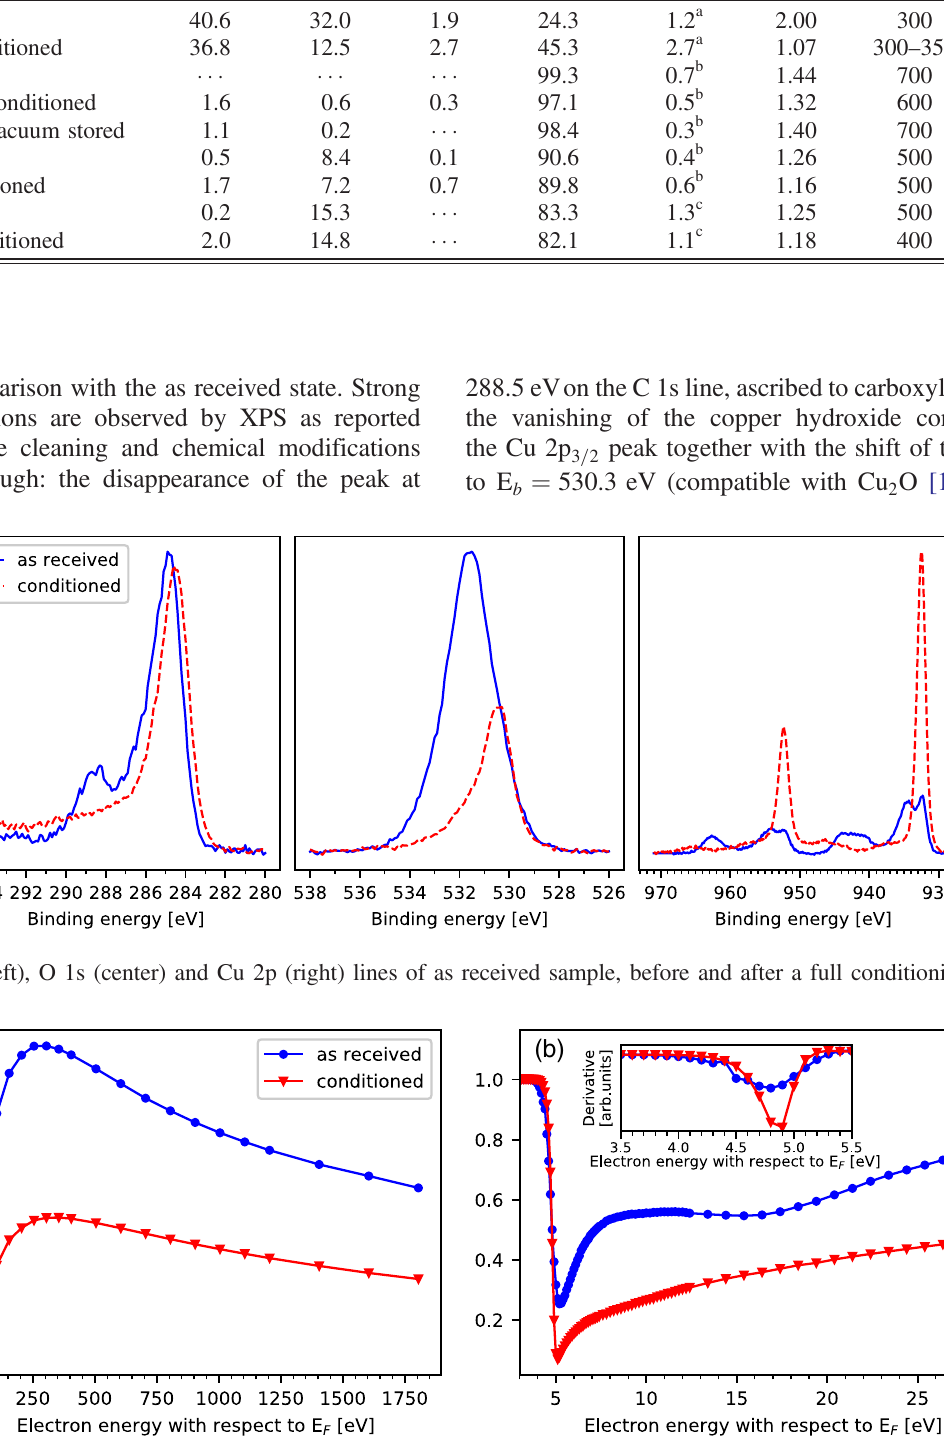
FIG. 3. (a) SEY curves from 10 to 1800 eVof an as received sample, before and after full conditioning, (b) low energy SEY curves, inset: derivative of the SEY curves in the vacuum level